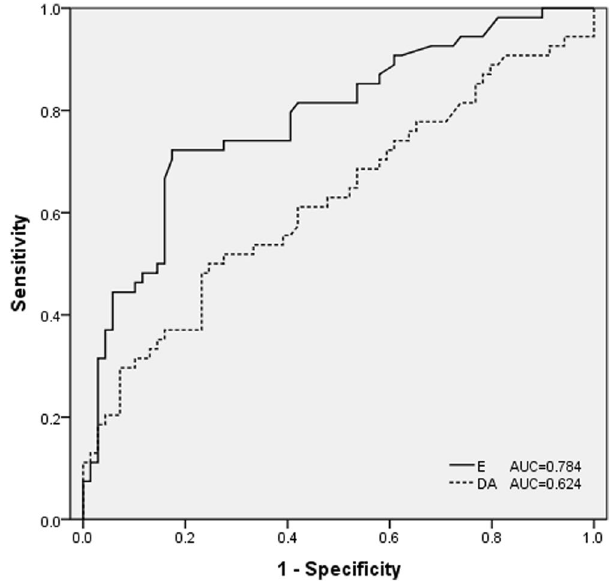
Figure 1. Receiver operating characteristic curve of multiples of the normal reference upper limit value of urinary E and DA. Cut-off points: multiples of the normal reference upper limit value of E, 0.5; multiples of the normal reference upper limit value of DA, 0.6. AUC, area under the curve; DA, dopamine; E,